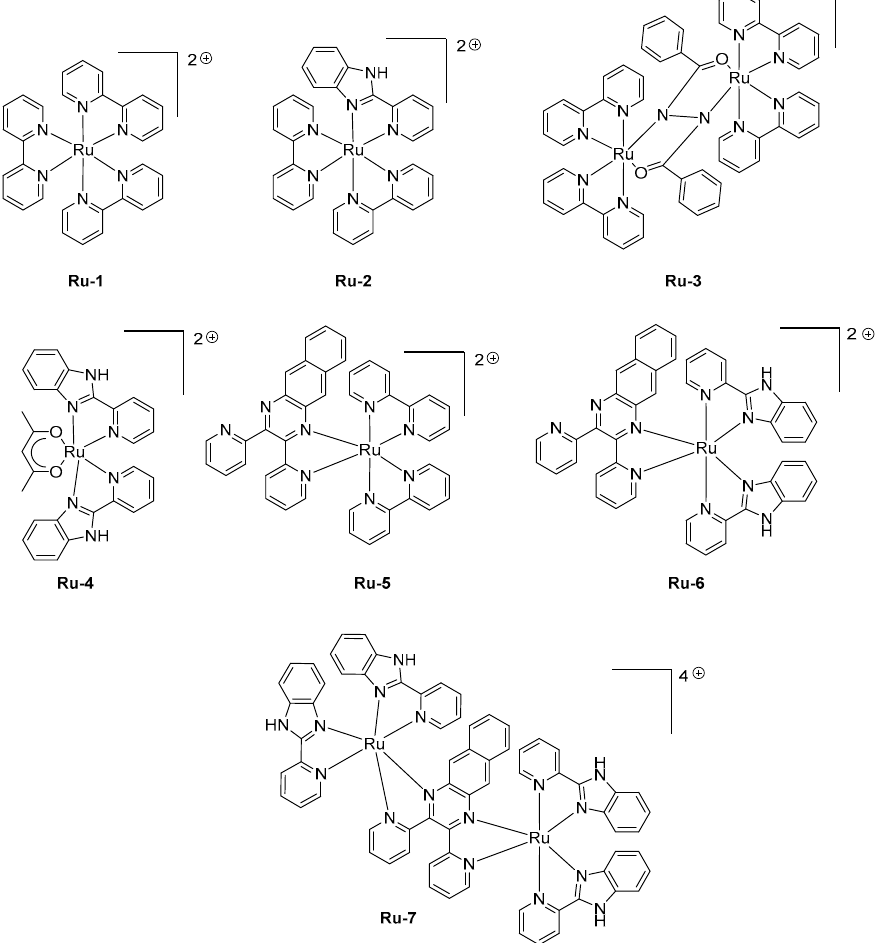
Figure 5. Ru-based near-infrared (NIR) emitters for light-emitting electrochemical cells.